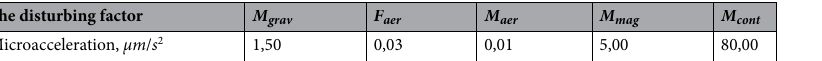
Table 1. There are maximum values of microaccelerations from the estimated disturbing factors. Where M grav is gravitational disturbance moment; F aer is aerodynamic disturbance force; M aer is aerodynamic disturbance moment; M mag is magnetic disturbance moment; M cont is control torque of magnetic actuators.